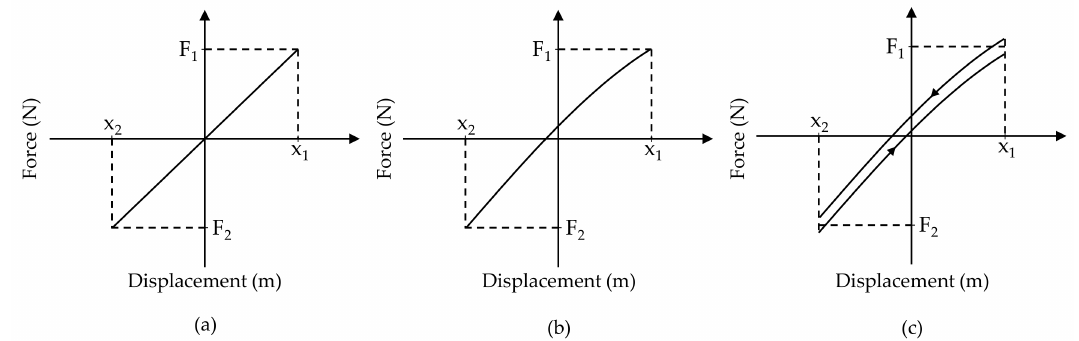
Figure 3. Examples of force-displacement relationship according to suspension type: ( a ) ideal ( b ) non-linearity and ( c )